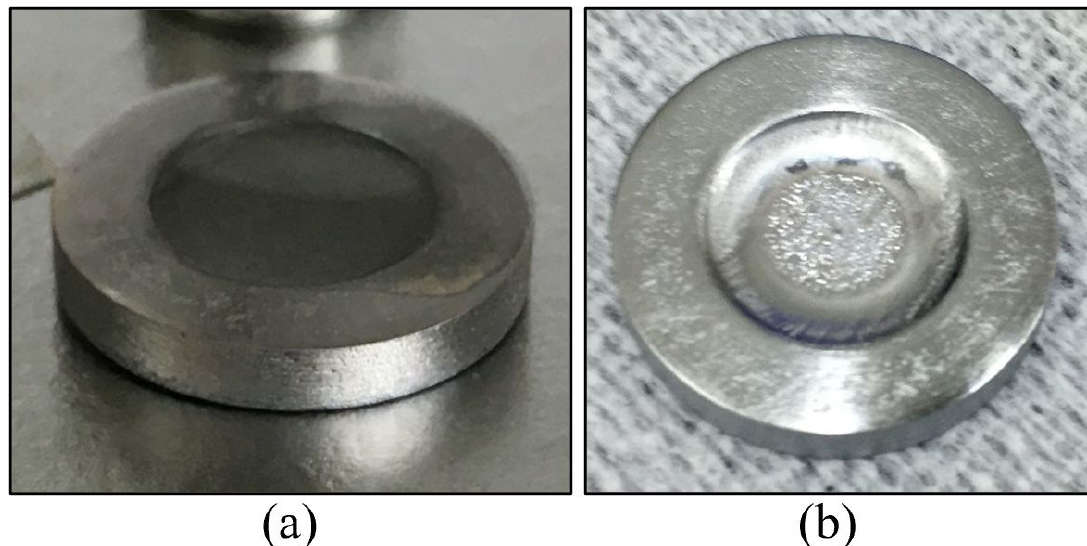
Figure 10. Sample prepared to analyze the melting of eutectic alloy of Mo-Ru system, (a) before melting (b) after melting.